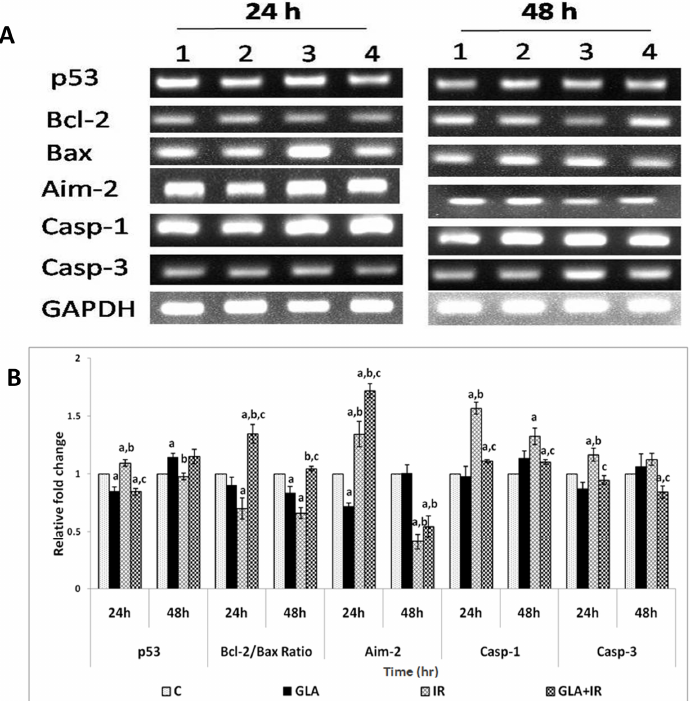
Figure 8. Effect of GLA and irradiation on genes associated with apoptotic pathways in RAW 264.7 cells at 24 and 48 h post-irradiation ( A , B ). Values (n = 3) expressed as mean ± SEM. a , b , c Significant ( p < 0.01) when compared with control, GLA, and irradiation, respectively. 1, C; 2, GLA; 3, IR; and 4, GLA + IR. C, control; GLA, gamma-linolenic acid; IR, irradiation (2 Gy). 3.2. In Vivo Studies 3.2.1. GLA Protects Mice against Whole-Body Lethal Radiation Our initial study revealed that of all the fatty acids tested, GLA was the most effective in protecting the animals from radiation-induced mortality (see Figure 9 for the protocol of the studies; the protocol is shown for GLA only, and the same protocol was used for studying the effect of other fatty acids, including LXA4. Figure 10 describes the control and GLA treatments (10, 50, and 100 μ g/kg)). GLA and other fatty acids, including LXA4, employed in the study did not produce any change in the survival of C57BL/6J female animals during the period observed (see Figure 10). Irradiated mice showed 16.7% sur- vival upon observation for 30 days. It is clear from the data shown in Figure 10 that GLA